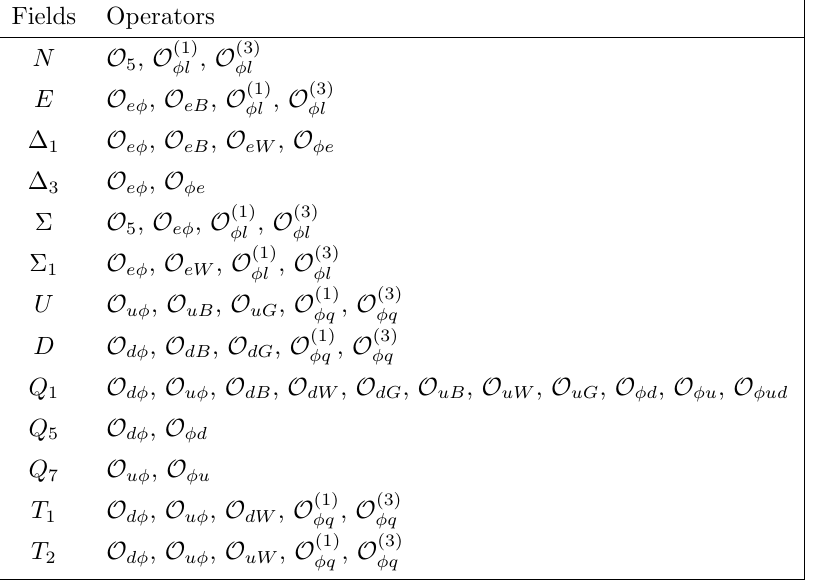
Table 8 . Operators generated by the heavy vector-like fermions in table 2.